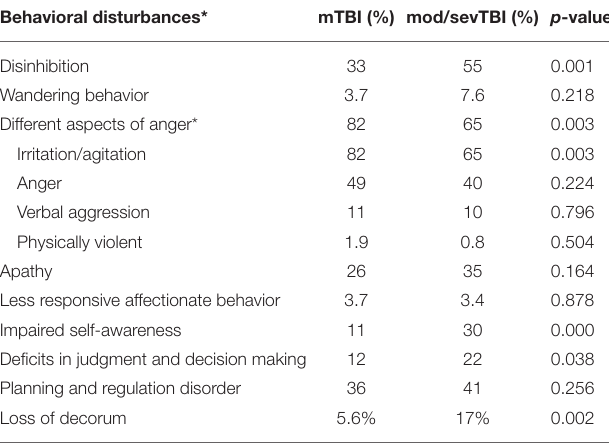
TABLE 1 | Patient characteristics.